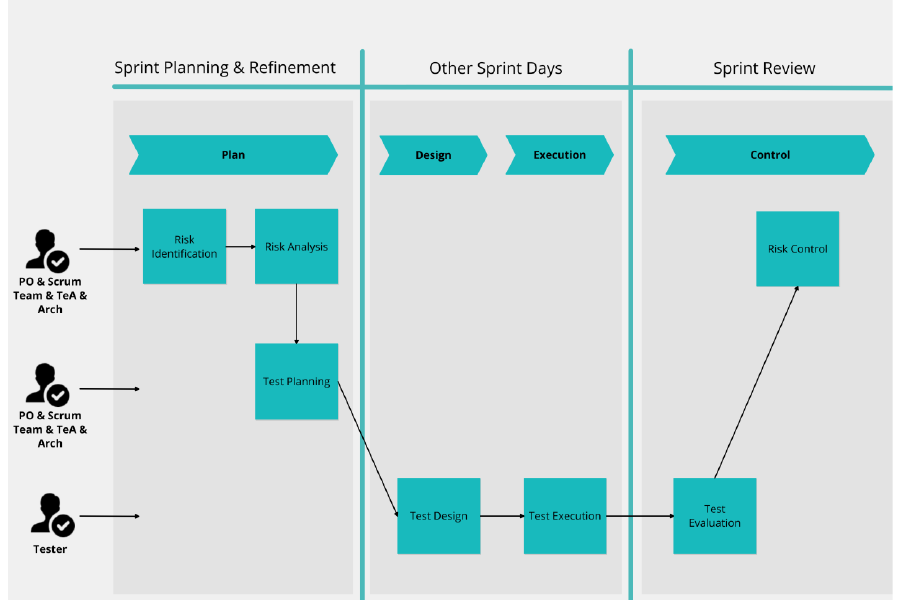
Figure 1. The risk-based testing approach in agile